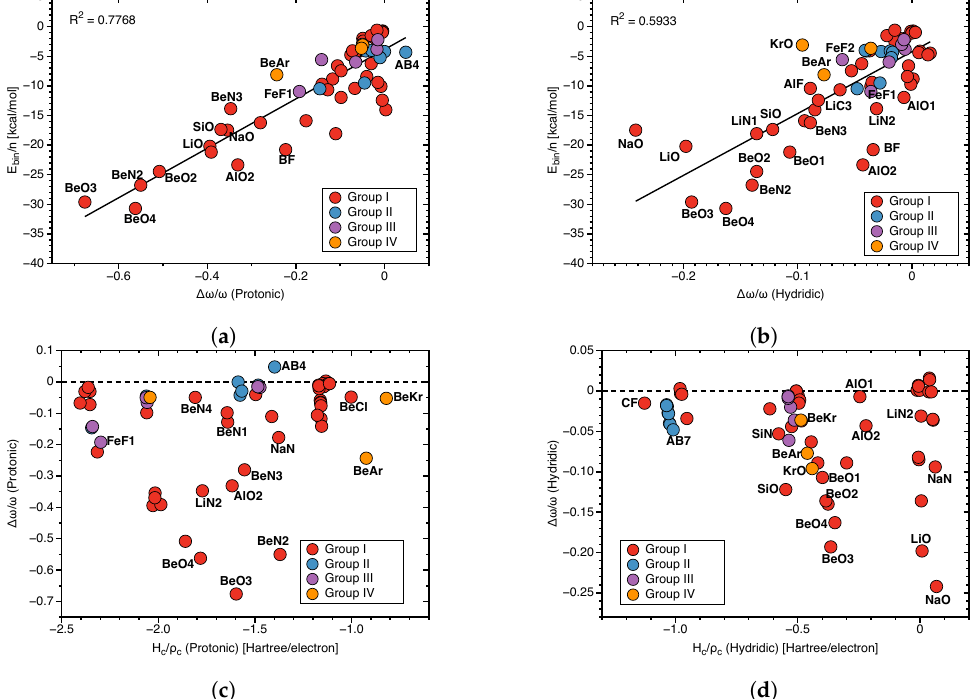
Figure 8. ( a ) Correlation between E bin /n and ∆ ω / ω (Protonic). ( b ) Correlation between E bin /n and ∆ ω / ω (Hydridic). ( c ) Correlation between H ∆ ω / ω (Protonic). ( d ) Correlation of c / ρ c (Protonic) and H c / ρ c (Hydridic) and ∆ ω / ω